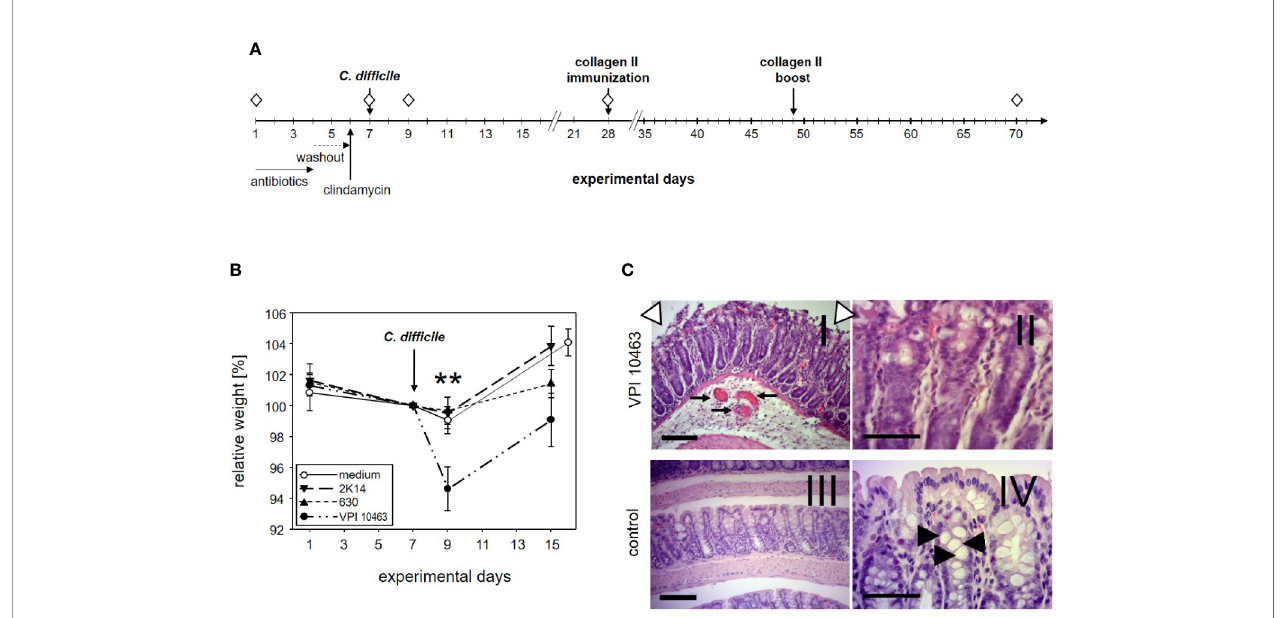
FIGURE 1 | DBA/1J × B10.Q F1 mice are susceptible to Clostridioides dif fi cile infection. (A) Experimental setup of C. dif fi cile infections. (B) Mean (± SEM) relative weight curves of mice gavaged with bacterial growth medium (n = 14) and infected mice (630: n = 19, 2K14: n = 16, VPI10463: n = 16). Asterisks denote statistically signi fi cant (**p-value = 0.0033) weight differences between experimental groups. (C) H&E stained 4 µm sections of colonic tissue depict erosive colitis on day 2 after infection with “ summit lesions ” (compare open arrowheads in I to edge of mucosal layer in IV), reduced numbers of vesicles (compare II and arrowheads in IV), thickened submucosal layer with in fl ammatory in fi ltrates, and capillary vessels in I (arrows). Scale bars represent 100 µm (I and III) and 50 µm (II and IV),